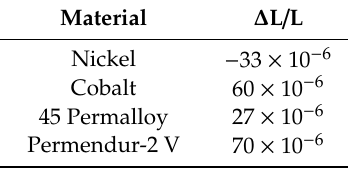
Table 3. Longitudinal magnetostriction of several elements and alloys.